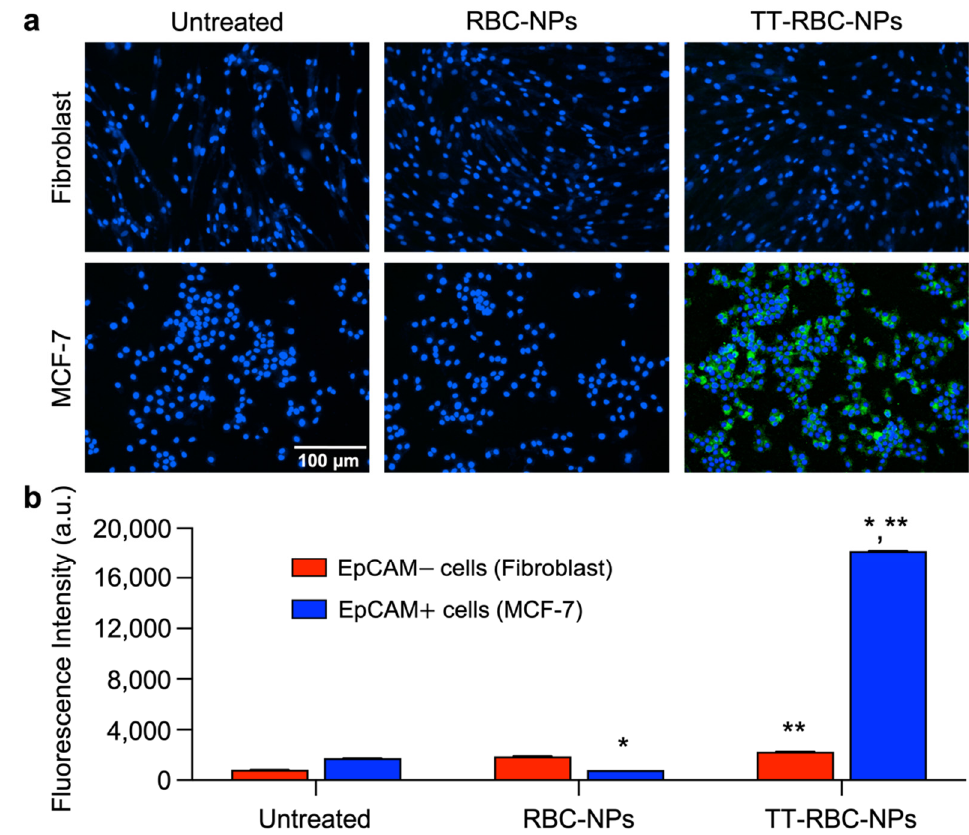
Figure 7. Targeting ability study of TT-RBC-NPs by fluorescence microscopy. ( a ) Fluorescence microscopy images of MCF-7 (EpCAM+) and skin fibroblast (EpCAM–) treated with RBC-NPs (non- targeted NPs) and TT-RBC-NPs (targeted NPs). All samples were labeled with FITC (green channel). After 1 h incubation, cells were washed and incubated for another 1 h in fresh medium before imaging. The nucleus was stained with DAPI (blue channel). Scale bar = 100 µm. ( b ) Quantification of mean fluorescence intensities of RBC-NPs and TT-RBC-NPs on MCF-7 (EpCAM+) and skin fibroblast (EpCAM–) cells. Bars represent mean ± SD ( n = 3). * the significance between RBC-NPs of EpCAM+ cells (MCF-7) and TT-RBC-NPs of EpCAM+ cells (MCF-7) ( p < 0.05). ** the significance between TT-RBC-NPs of EpCAM– cells (fibroblast) and TT-RBC-NPs of EpCAM+ cells (MCF-7) ( p < 0.05).